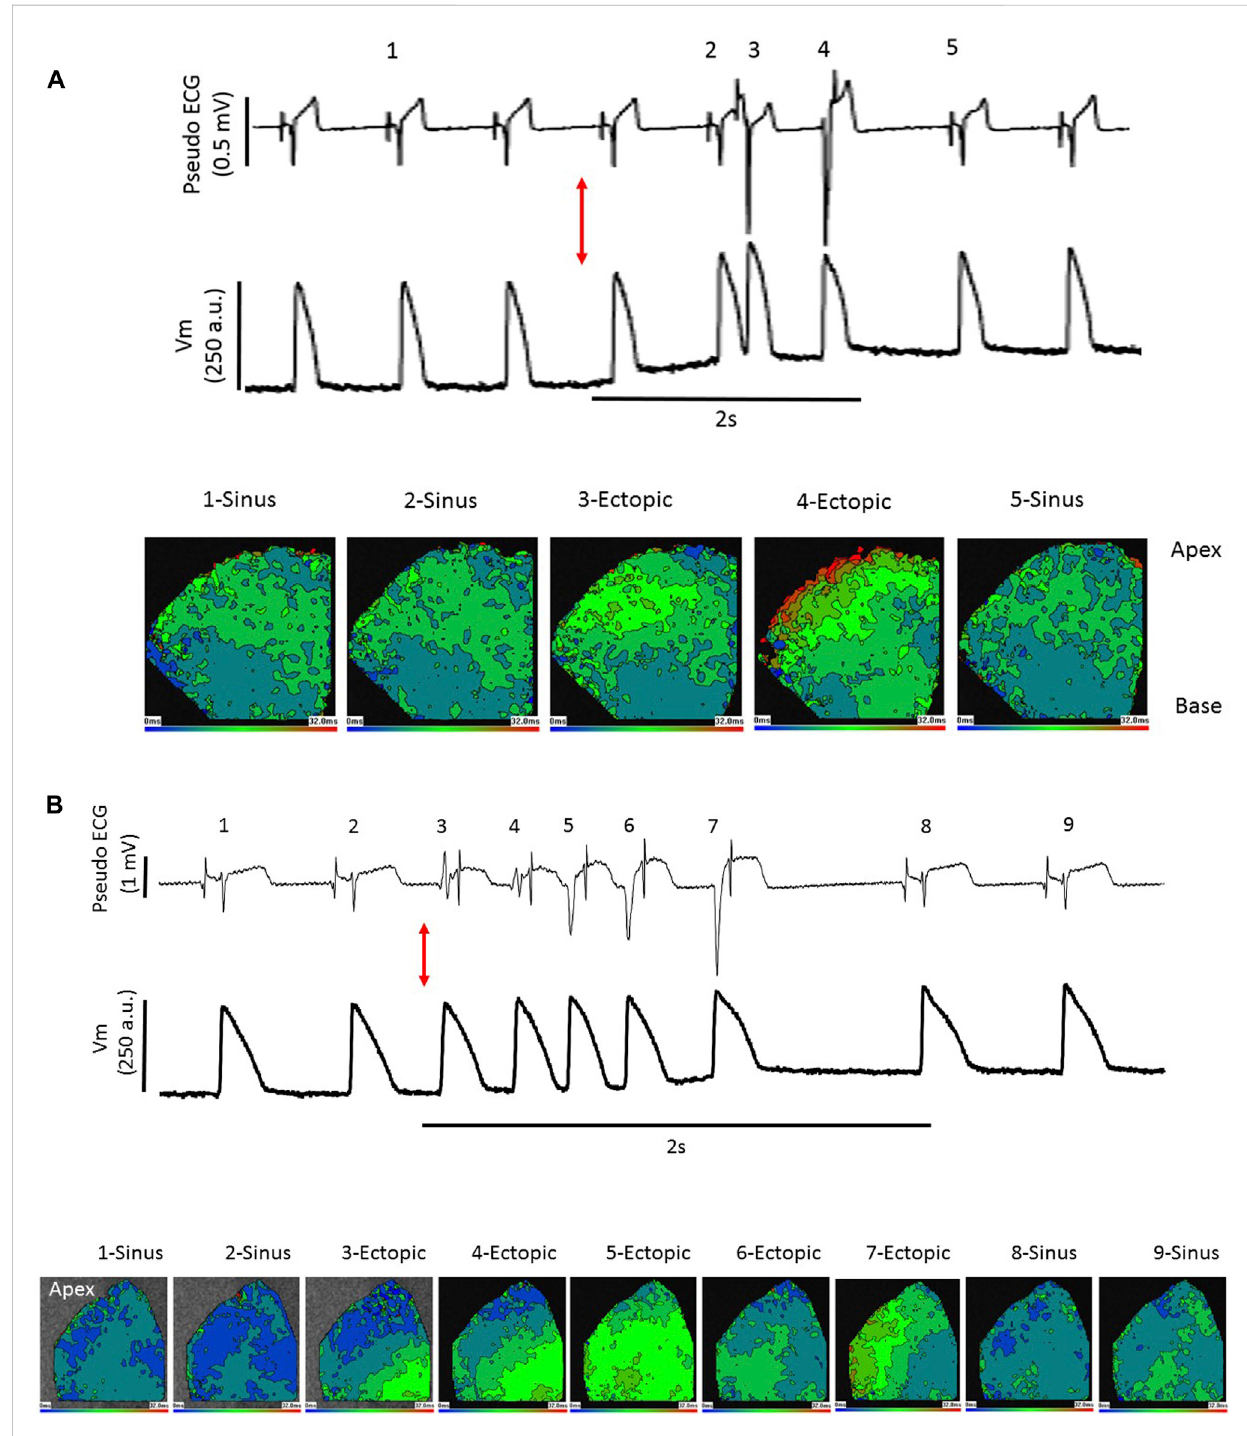
FIGURE 5 Stretch-induced ectopic activation mimics sinus and focal stimulation. Pseudo-ECG (upper trace), optically measured action potentials (middle trace) and epicardial activation maps, as described in Figure 4 (lower images), in the left ventricle (LV) of 2 Langendorff perfused rabbit hearts (A, B) . (A) at the red arrow the LV is dilated from 0.2 mL to 0.9 mL by in fl ation of an indwelling balloon over a 2 s period, triggering ectopics. Activation maps from selected points1 – 5show sinusstimulationsat1,2and5withbroad basaland apicalearlyactivation andtypicalrapidactivation spread.Excitations3 and 4 are ectopic. Activation 3 falls upon the t-wave of the preceding sinus beat but this does not trigger sustained arrhythmias, the activation pattern closely resembles that of sinus stimulation. There is some slowing of lateral conduction, possibly explained by the short preceding diastolic period. Excitation4has2focal-likeearlyactivationsites,inthebaseandlaterally,andconductionisslowerthantheother4excitations. (B) attheredarrowtheLV is dilated from 0.2 mL to 0.9 mL by in fl ation of an indwelling balloon over a 2 s period, triggering ectopics. A sequence of 2 sinus excitations 1 and 2 followedby5self-terminatingectopicexcitations3 – 7andthefollowing2re-establishedsinusexcitations8and9areshown.Inthisheartsinusexcitation leads to lateral early activation. This is mimicked by ectopics 3 and 6 but ectopics 4, 5 and 7 have distinct patterns. Dilation-induced ectopics are multi- focal and typically within a single ectopic period, there are varied activation